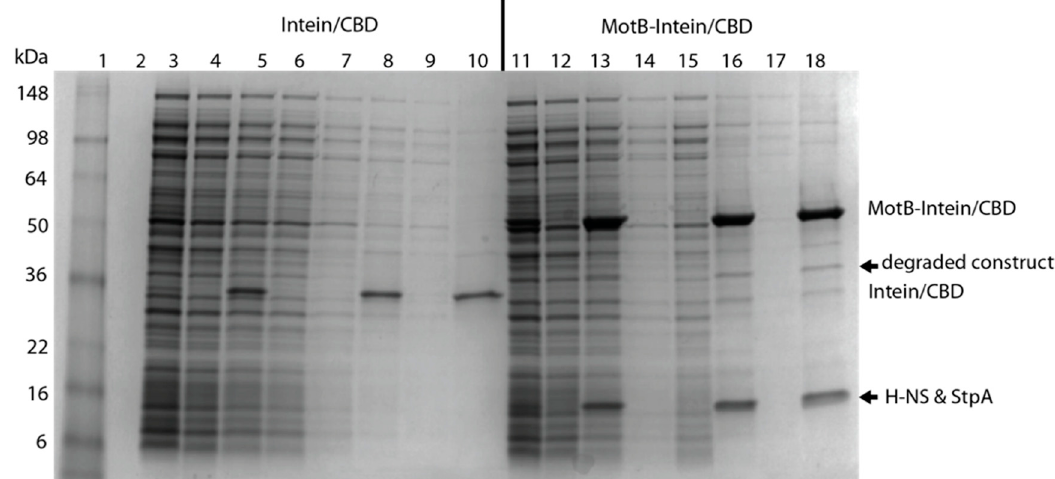
Figure 5. MotB copurifies with H-NS and StpA. An SDS-PAGE gel, stained with Coomassie, is shown for the following samples obtained from BL21(DE3)/pLysE containing either the vector pTXB1 (lanes 3–10) or pTXB1-MotB (lanes 11–18): lysate applied to chitin resin (lanes 3 and 11); column flow through (lanes 4 and 12); resin sample after flow through (lanes 5 and 13); first and second column wash with buffer containing 500 mM NaCl (lanes 6, 7 and 14, 15); resin sample after second 500 mM salt wash (lanes 8 and 16); column wash with buffer containing 1 M NaCl (lanes 9 and 17); final resin sample after 1 M salt wash (lanes 10 and 18). Lane 1 corresponds to SeeBlue Plus2 protein standard; corresponding molecular weights are shown on the left. Bands corresponding to MotB-Intein/CBD and Intein/CBD are indicated. Species indicated with arrows were identified by mass spectrometry. The ~36 kDa protein labeled as “degraded construct” was identified as partially degraded MotB-Intein/CBD. The ~16 kDa protein was identified as H-NS and